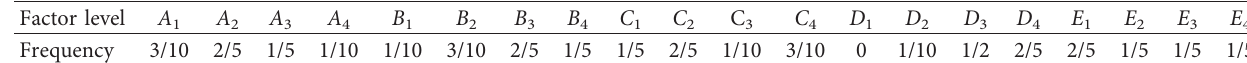
Table 9: Frequency table of each factor level.